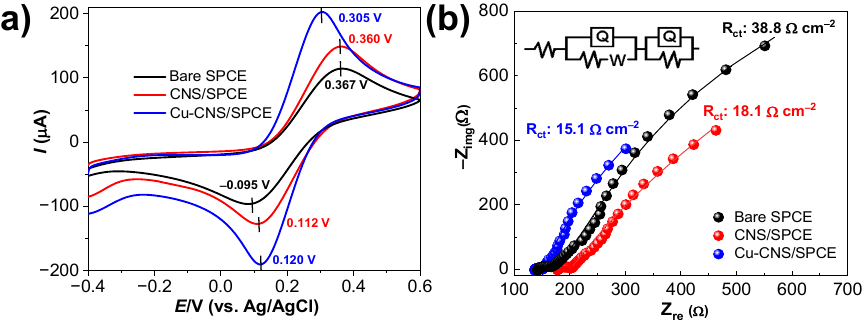
Figure 3. ( a ) CV responses of the modified sensors in 5 mM of Fe(CN) 6 ] 3−/4− in 0.1 M KCl redox probe at 50 mV s −1 scan rate. ( b ) EIS responses of the modified sensors in the same redox probe. Inset: the fitted equivalent circuit.